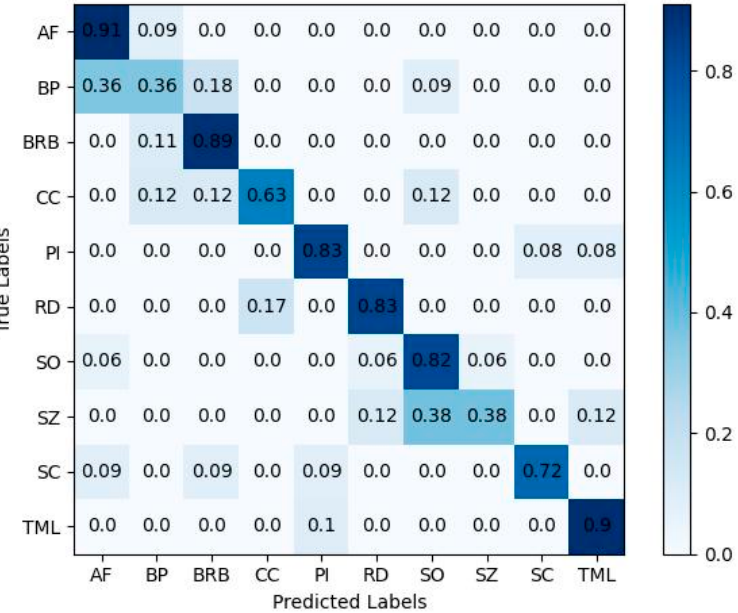
horizontal axis represents the predicted label. The values in the diagonal area in the figure are the pro-